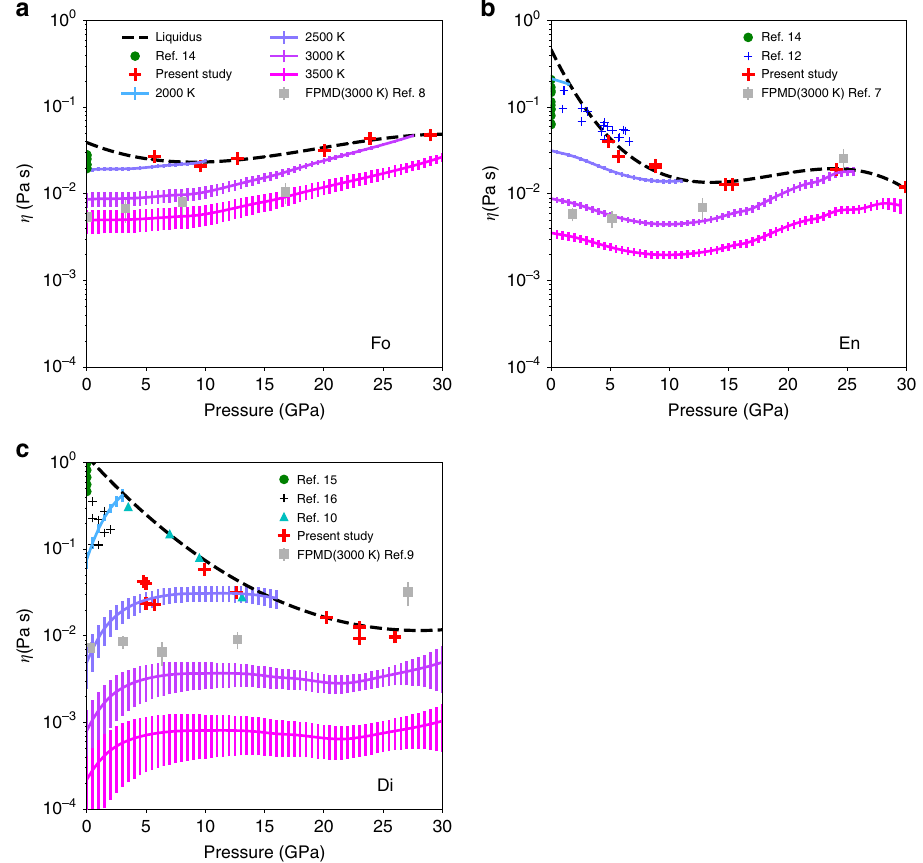
Fig. 2 Viscosities of silicate melts under pressure. a – c Fo, En, and Di composition, respectively. We report our experimental data as red crosses, whose temperatures are shown in Supplementary Fig. 2 and Supplementary Table. 1. Dashed black lines are viscosities along liquidus. Colored lines are viscosities recalculated along isotherms with their 1 σ standard